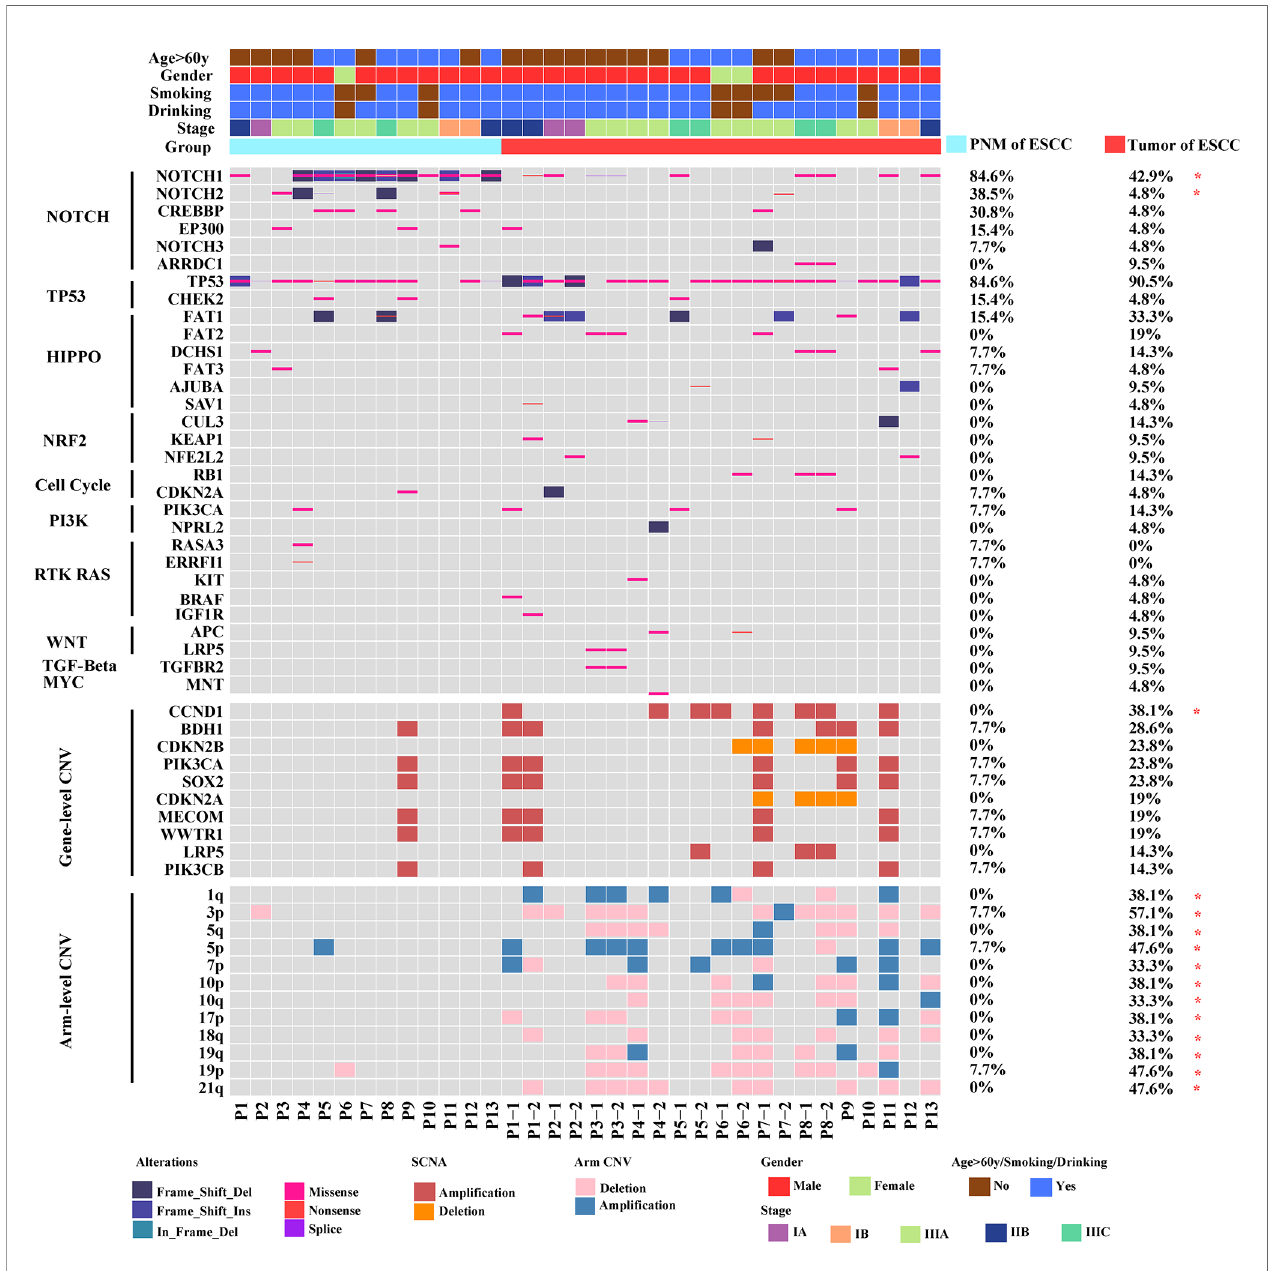
FIGURE 1 | Mutational landscapes of ESCC PNM and tumor samples by whole-exome sequencing. The age, gender, smoking, drinking, stage (determined according to the 8 th Edition American Joint Committee on Cancer (AJCC) staging system for esophageal cancer), and group information are listed for each sample. In the mutational landscapes, top panel: SNV type, related signaling pathway, and frequencies in ESCC PNM and tumor; middle panel: gene copy number variations and their frequencies in ESCC PNM and tumor; bottom panel: chromosomal arm level copy number variations and their frequencies in ESCC PNM and tumor (*: statistically signi fi